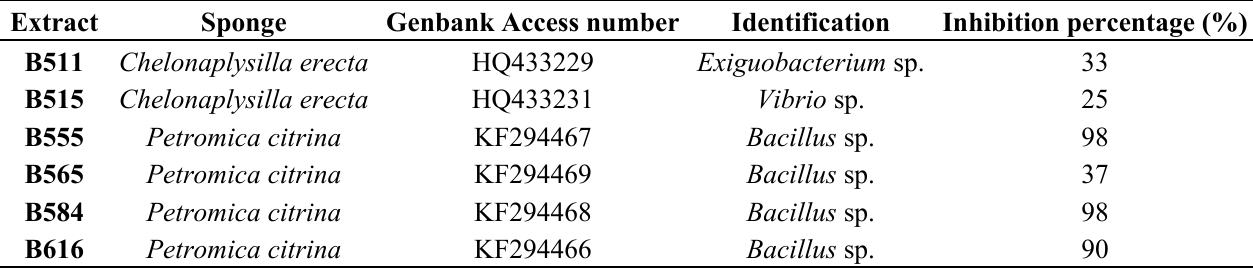
Table 1. General characteristics of the extracts evaluated for antiviral